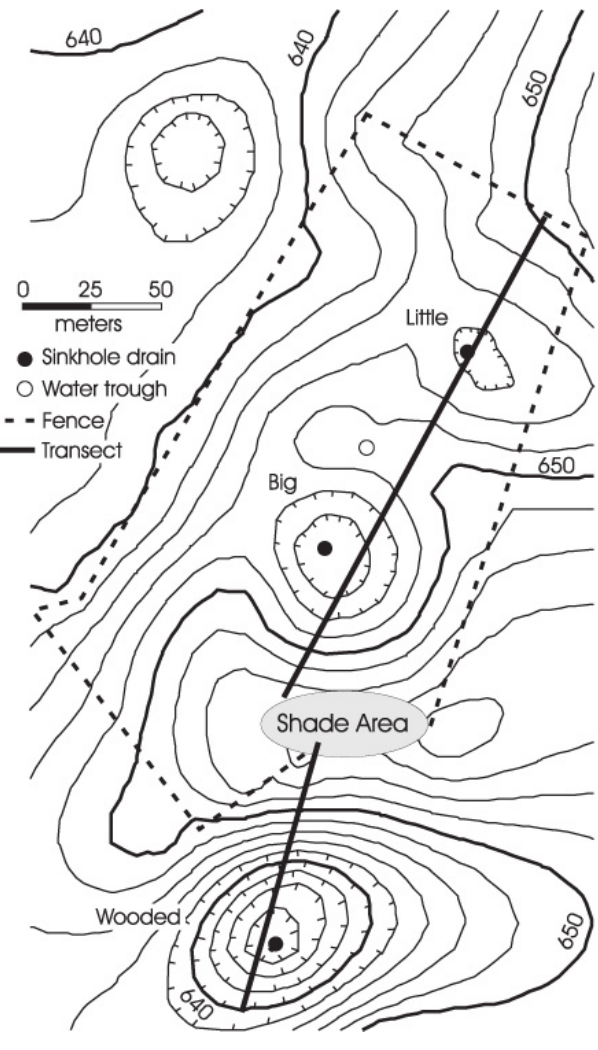
FIGURE 1. Contour map of the study site. Contour interval = 2